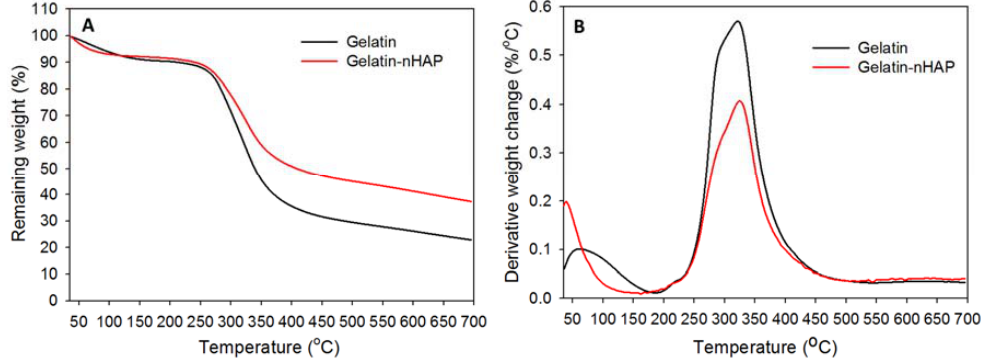
Figure 7. ( A ) Thermogravimetric analysis (TGA) and ( B ) differential thermogravimetric (DTG) analysis of gelatin and gelatin ‐ nHAP